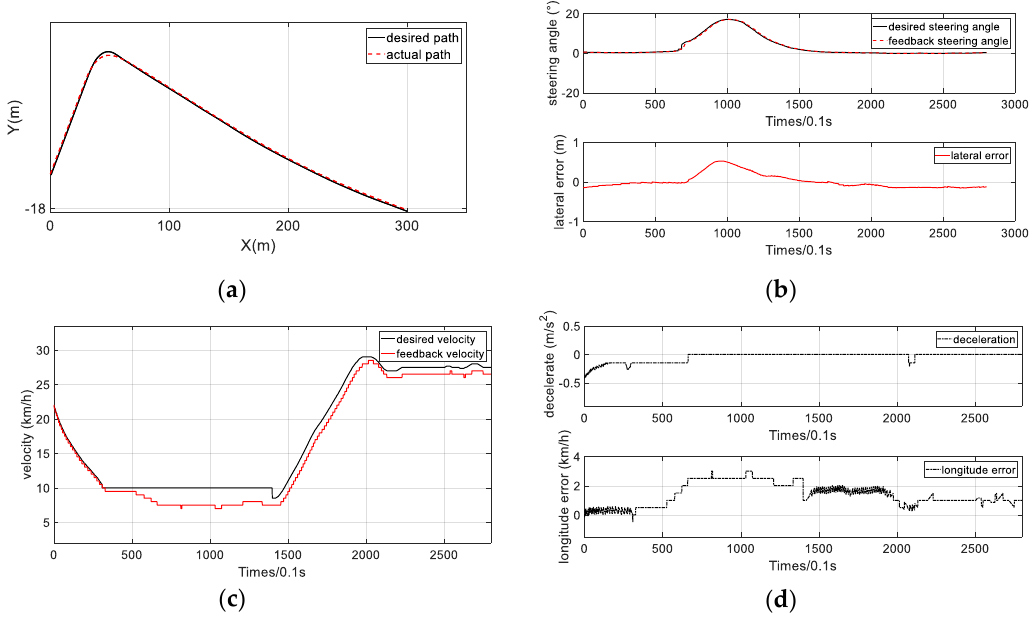
Figure 22. Results of real driverless bus experiments. ( a ) Desired path and actual path of bus. ( b ) Steering angle and lateral error. ( c ) Desired velocities and feedback velocities. ( d ) Deceleration and longitudinal error.